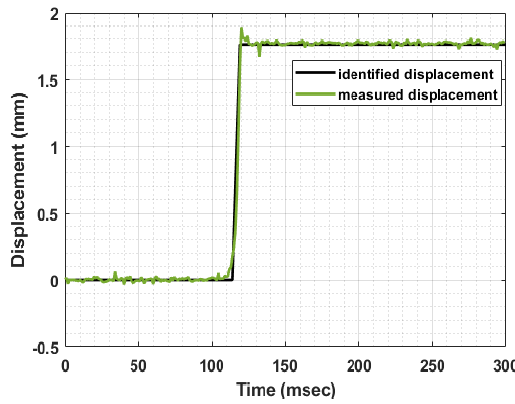
Figure 17 Comparison between identified and measured displacement when the solenoid is energized